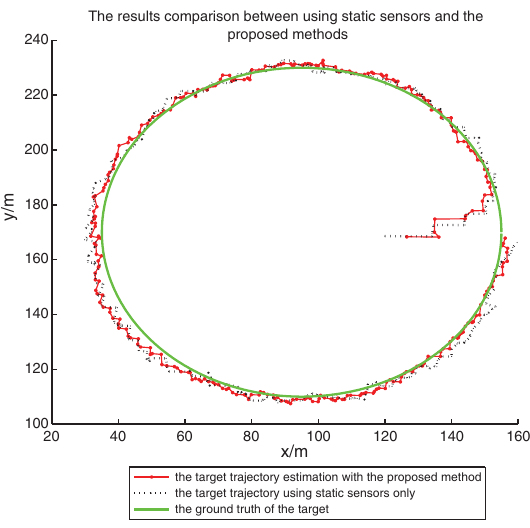
Fig. 2. Tracking results comparison with/without mobile sen-